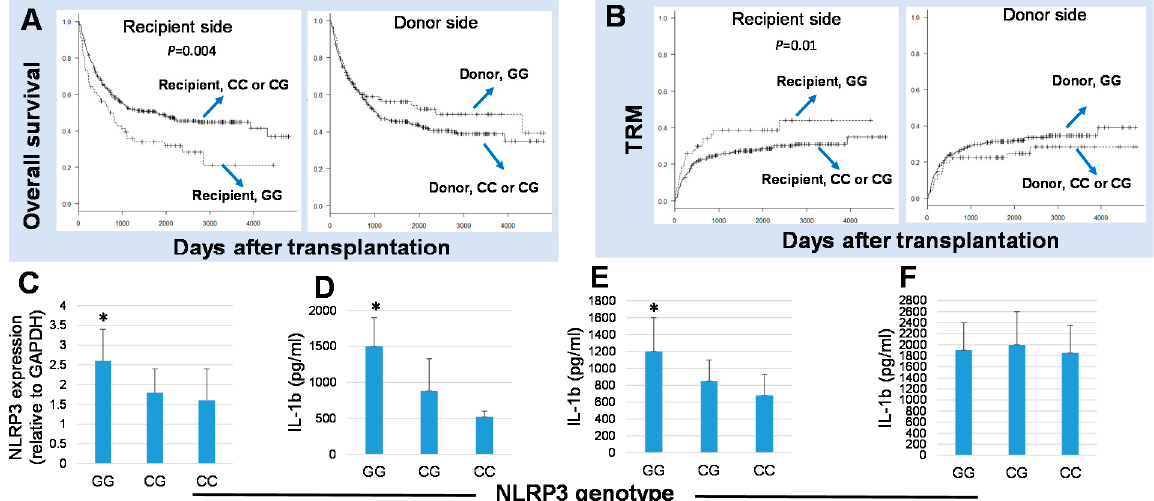
Figure 1. NLR family pyrin domain-containing 3 (NLRP3) genotypes influenced transplant outcomes after HSCT and also influenced IL-1 β secretion in response to NLRP3 activation. The Kaplan–Meier analysis of the 5-year overall survival (OS) ( A ) and the transplant-related mortality rates (TRM) ( B ) after transplantation according to the recipient and donor NLRP3 genotypes. Recipients with the G/G genotype of NLRP3 at r s10754558 had the worst 5-year overall survival compared to those with the C/C or C/G genotypes (hazard ratio (HR), 1.86; 95% confidence interval (CI), 1.22–2.22; p = 0.004; higher TRM, HR, 2.28; 95% CI, 1.20–4.35; p = 0.01). ( C ) RNA extracted from peripheral blood mononuclear cells (PBMCs) of 24 healthy individuals were subjected to RT-PCR with TaqMan primers specific for the NLRP3 gene, and the analysis showed a significantly higher NLRP3 transcripts in individuals harboring the G/G genotypes in comparison to those with the C/C or C/G genotypes. Blood samples from 27 healthy individuals with the GG ( n = 8), CG ( n = 14), and CC ( n = 5) genotypes of rs10754558 NLRP3 were subjected to a whole blood culture assay for 16 h in the presence or the absence of LPS ( D ), the NLRP3 ligand MDP ( E ), or PHA ( F ), and the levels of IL-1 β released in the culture supernatant were determined by ELISA. * p < 0.05.